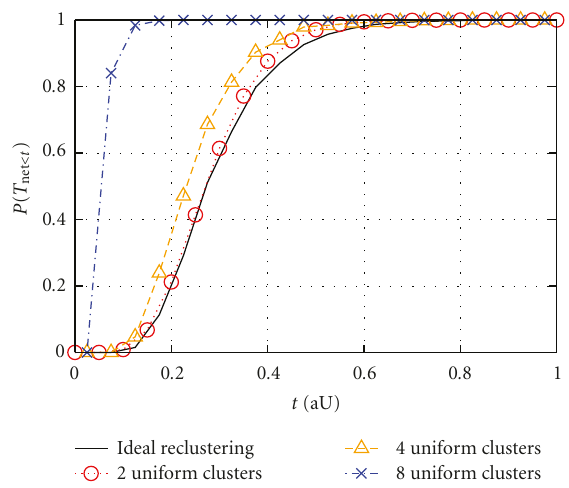
Figure 5: CDF of the network lifetime, as a function of time, in a scenario with N = 32 sensors, uniform clustering (with, resp., 2, 4, and 8 clusters), and absence of reclustering (simulation results). The sensor SNR is set to 5dB and the maximum tolerable probability of = 10 − 3 . For comparison, the curve associated decision error is P ∗ e with ideal reclustering (analytical results) is also shown. Each sensor has an exponential distribution.